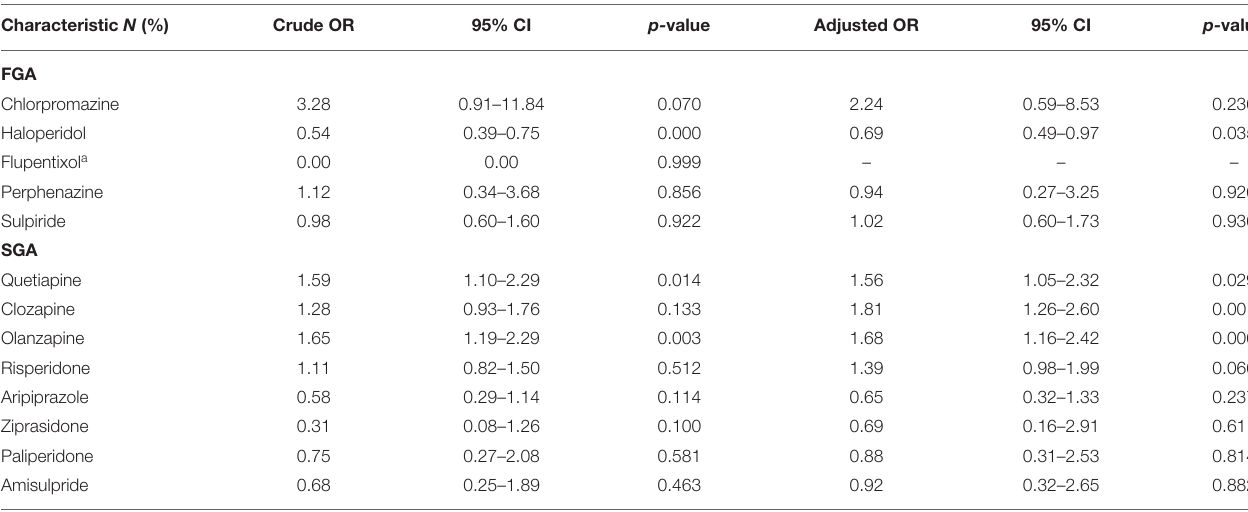
TABLE 2 | Risk analysis of antipsychotic drug use and HAP